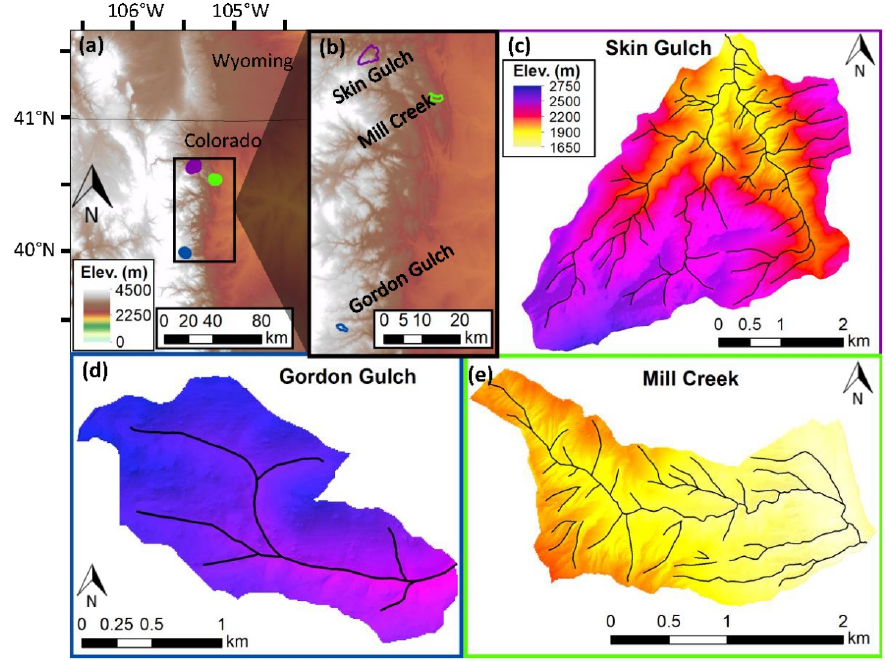
Figure 1. Map of the study catchments showing ( a ) locations within Colorado, ( b ) catchment boundaries, and ( c – e ) individual catchment elevations and National Hydrography Dataset (NHD) flowlines. Table 1. Summary of the studied catchments’